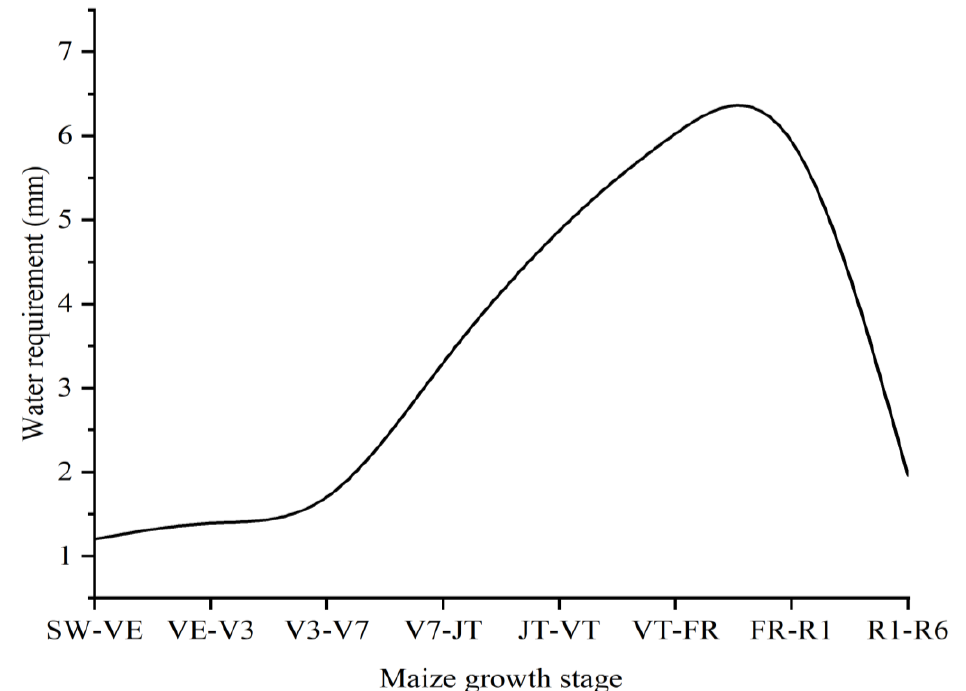
Figure 3. Daily water requirement during the maize growing stage in Northeast China. NOTE: SW: sowing stage; VE: emergence stage; V3: three-leaf stage; V7: seven-leaf stage; JT: jointing stage; VT: tasseling stage; FR: flowering stage; R1: silking stage; R6: harvesting stage.